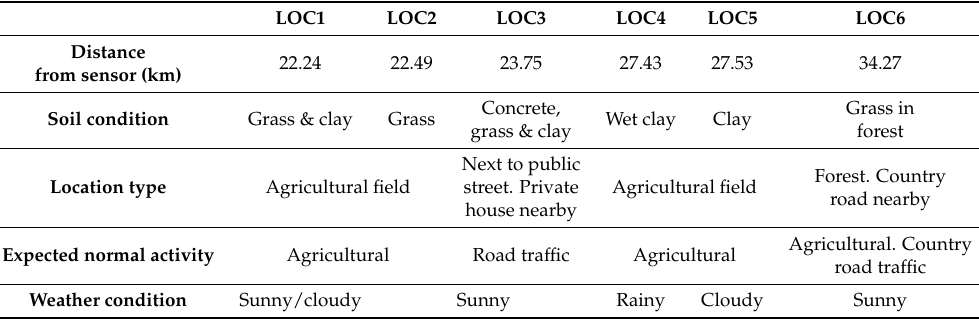
Table 2. Example of table showing the environmental and distance details on locations where data recordings took place (reproduced with permission from [23]. Copyright IEEE,